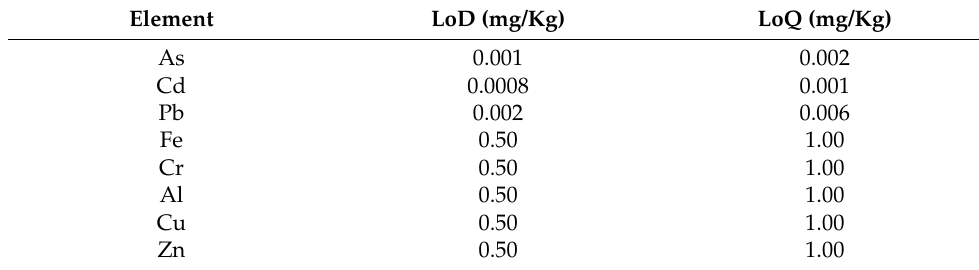
Table 2. Method detection and quantification